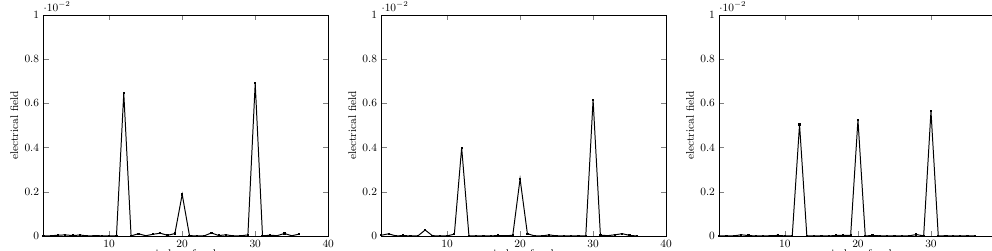
Figure 6. Retrieval for different radii, from left to right, R = λ /10, λ /12, λ /14. Spacing d is kept at λ /4. Missing rods (not shown) are of indexes 12, 20, and 30.